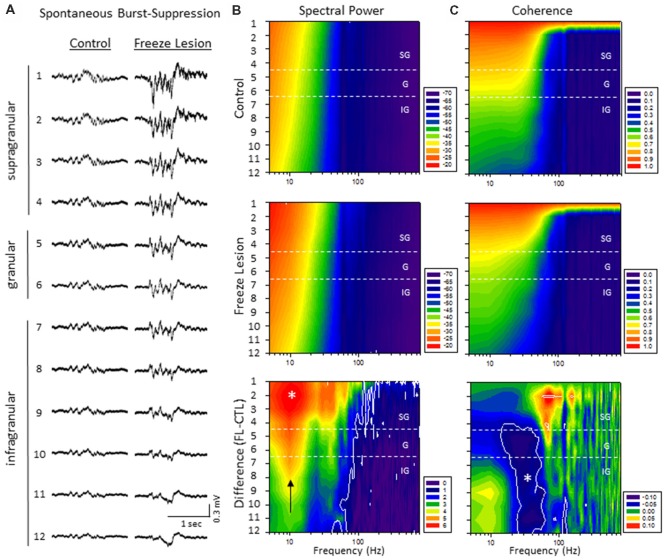
A significant increase in spectral power and altered spectral coherence pattern were observed in the malformed cortex of freeze lesion animals as indicated from spectral analysis of linear electrode array recordings of anesthesia induced B-S. (A) Representative micro-electrode recordings of B-S events across cortical lamina from a control and freeze lesion animal under general anesthesia (2% isoflurane). (B) Average spectral power maps of control, freeze lesion, and the difference between each map. Black arrow indicates peak 10 Hz increase in PSD values from freeze lesion vs. control animals. (C) Average spectral LFP coherence maps of control, freeze lesion, and the difference between each map. (B,C) Values represent the group means from control (n = 12) and freeze lesion (n = 20) recordings. The topographic lines (solid white) indicate the P < 0.05 cutoff threshold and the white asterisks designate regions significantly different between groups (Holm-Sidak post hoc analysis). See “Results” section for additional statistical analysis.